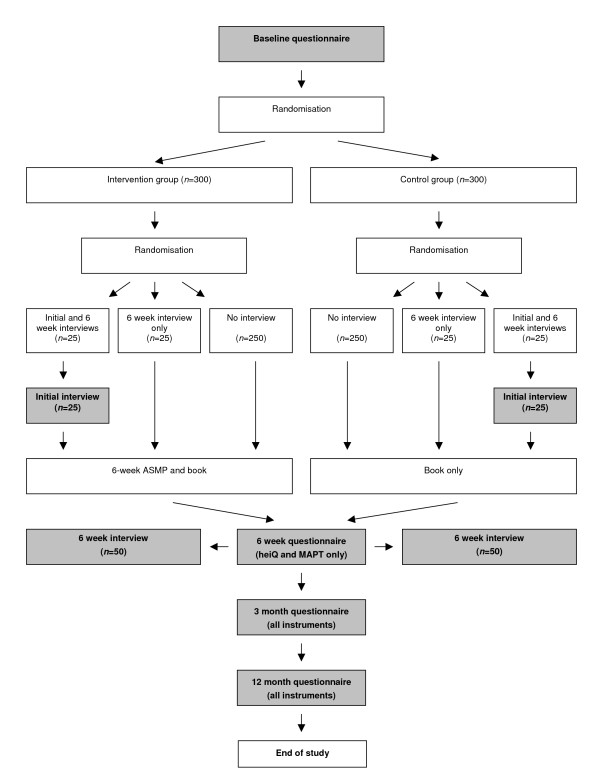
Study design and assessment points.